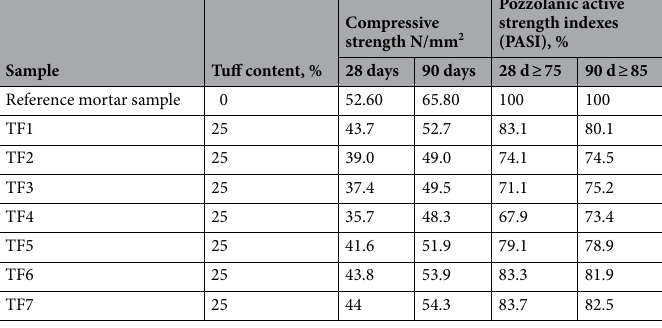
Table 5. Compressive strength and pozzolanic active strength indexes of Tuff samples.